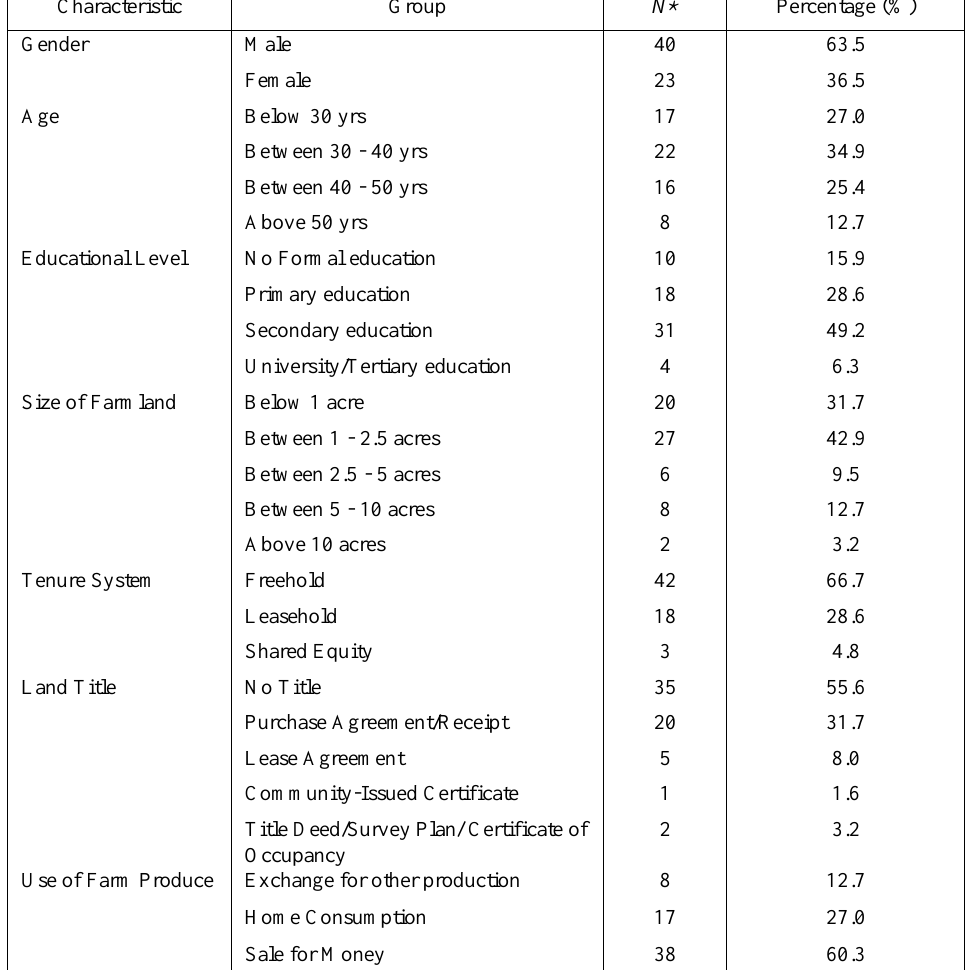
Table 1. Demographic and socioeconomic characteristics of the farmers N* - number of respondents = 63 (Source: Questionnaire survey, 2019)